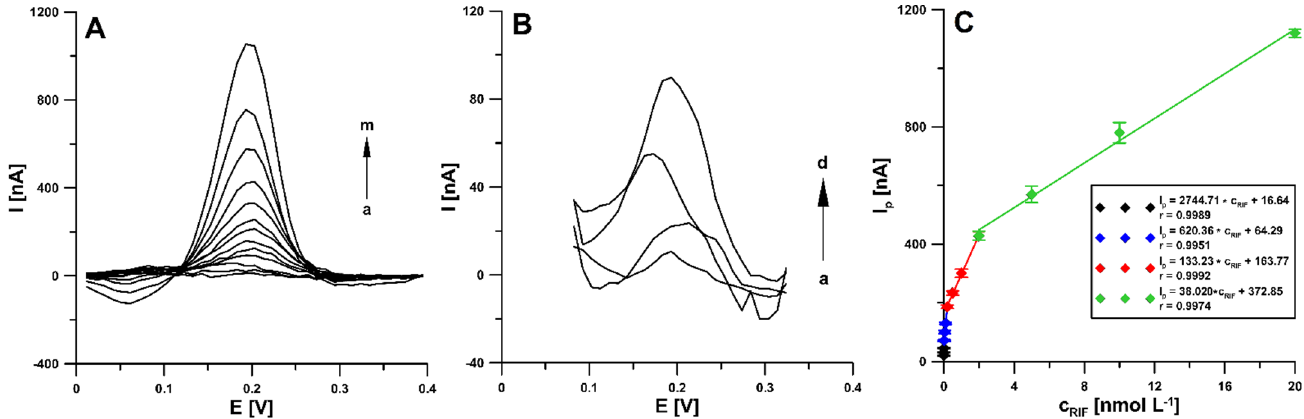
Figure 9. ( A ) DPAdSV curves recorded at the aSPBDDE in the PBS solution of pH 3.0 ± 0.1 containing increasing concentrations of RIF: (a) 0.002, (b) 0.005, (c) 0.01, (d) 0.02, (e) 0.05, (f) 0.1, (g) 0.2, (h) 0.5, (i) 1.0, (j) 2.0, (k) 5.0, (l) 10.0, (m) 20.0 nM. ( B ) DPAdSV curves for the RIF concentration: (a) 0.002, (b) 0.005, (c) 0.01, (d) 0.02 nM. ( C ) Calibration plot of RIF. The DPAdSV parameters: Eacc of − 0.45 V, tacc of 120 s, Δ E A of 150 mV, ν of 100 mV s − 1 and t m of 5 ms. Table 1. Comparison of different methods for RIF determination.